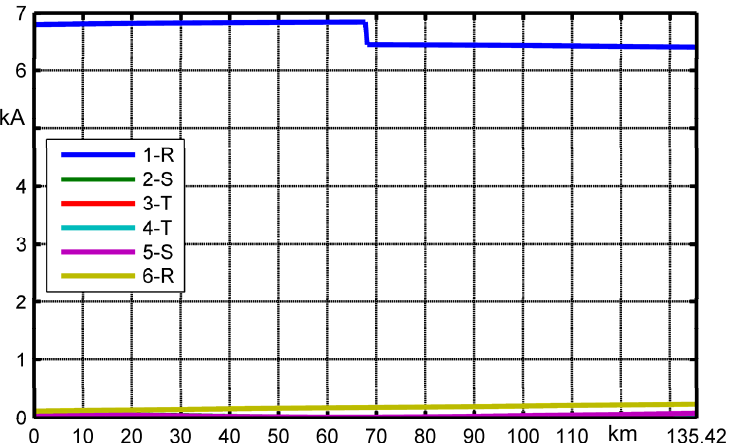
Figure 17. Phase current magnitudes along the line.